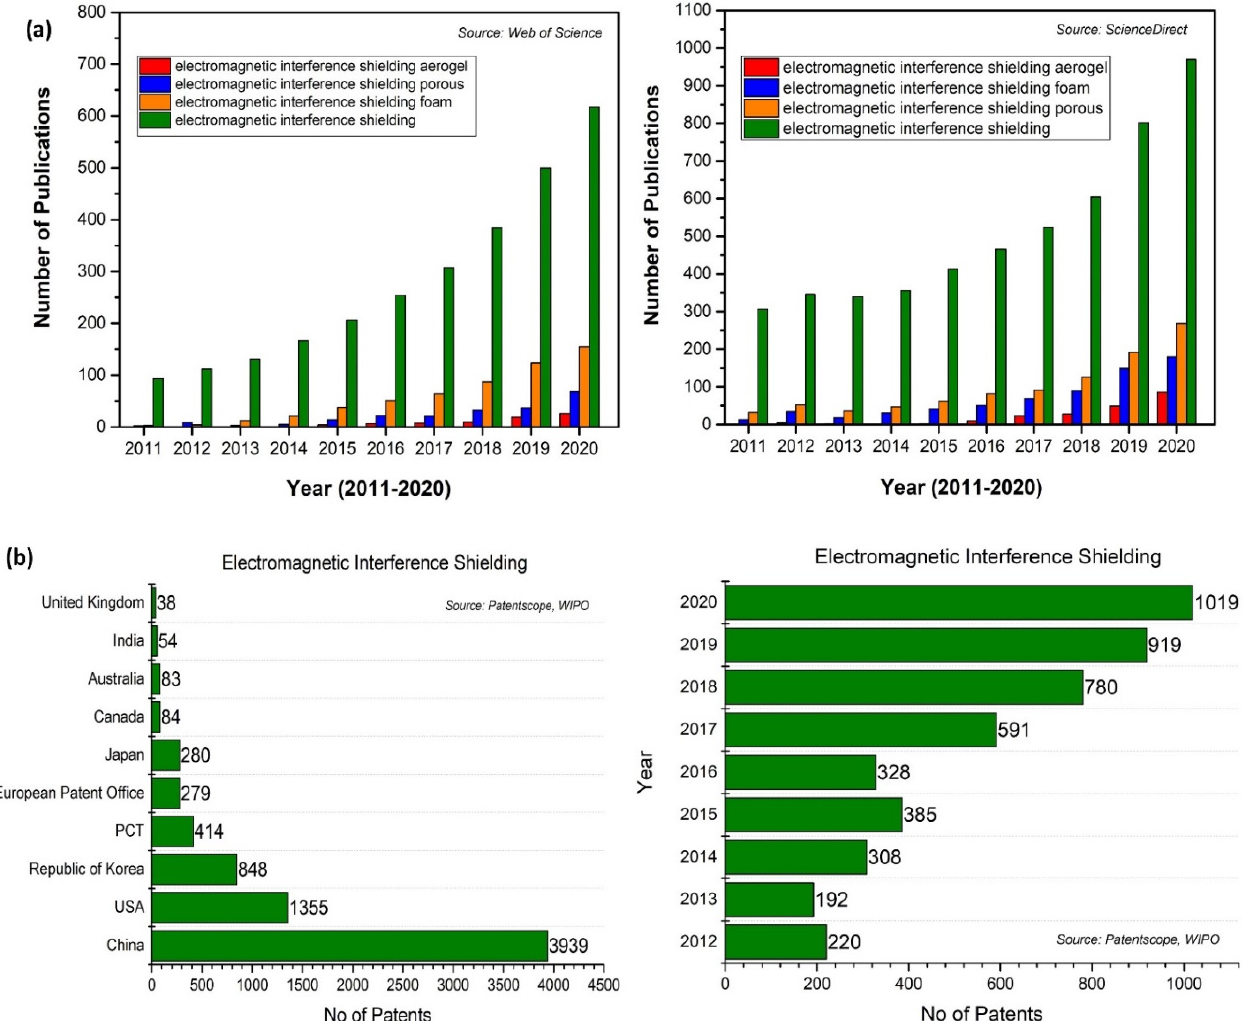
Figure 1. ( a ) Year-wise number of publications and ( b ) patents in the area of porous EMI shielding materials (foams and aerogels) over the last decade (2011–2021).